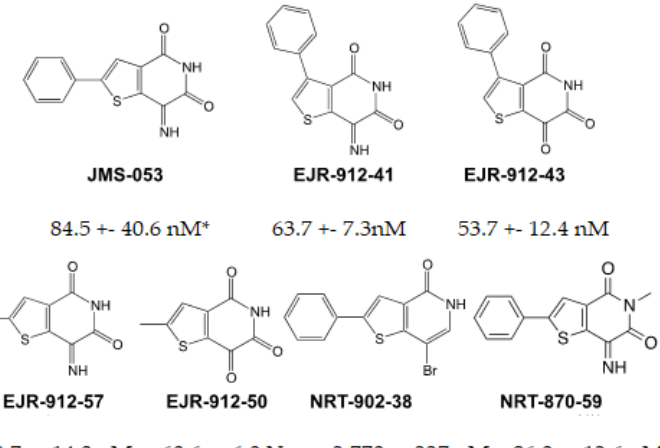
Figure 3. Chemical structures of the inhibitors and in vitro IC 50 against recombinant human PTP4A3. Mean ± SEM, N = 3, unless indicated by * N = 6 or ** N = 8.